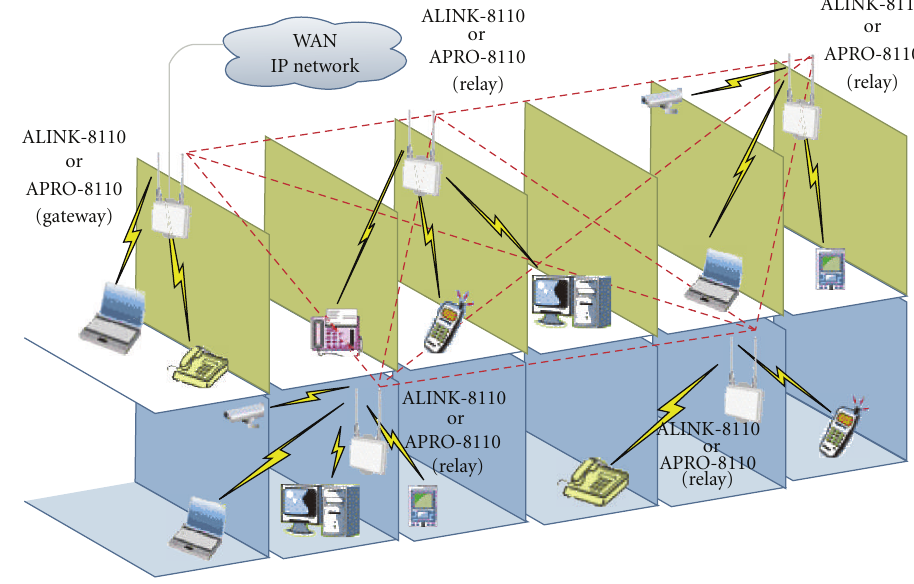
Figure 2: Wireless mesh network.